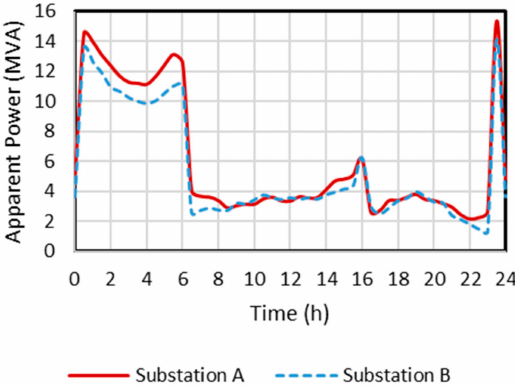
Figure 5. Apparent power flows through transformers after the introduction of DR scheme for scenario 1.